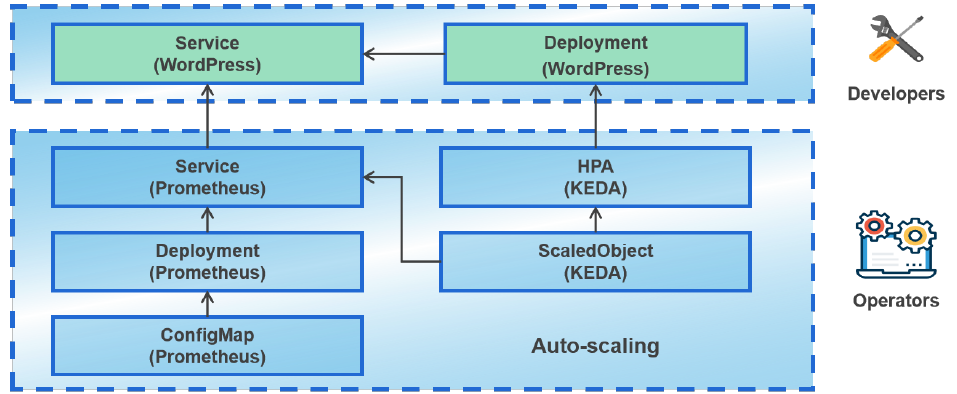
Figure 9. Key components of WordPress application